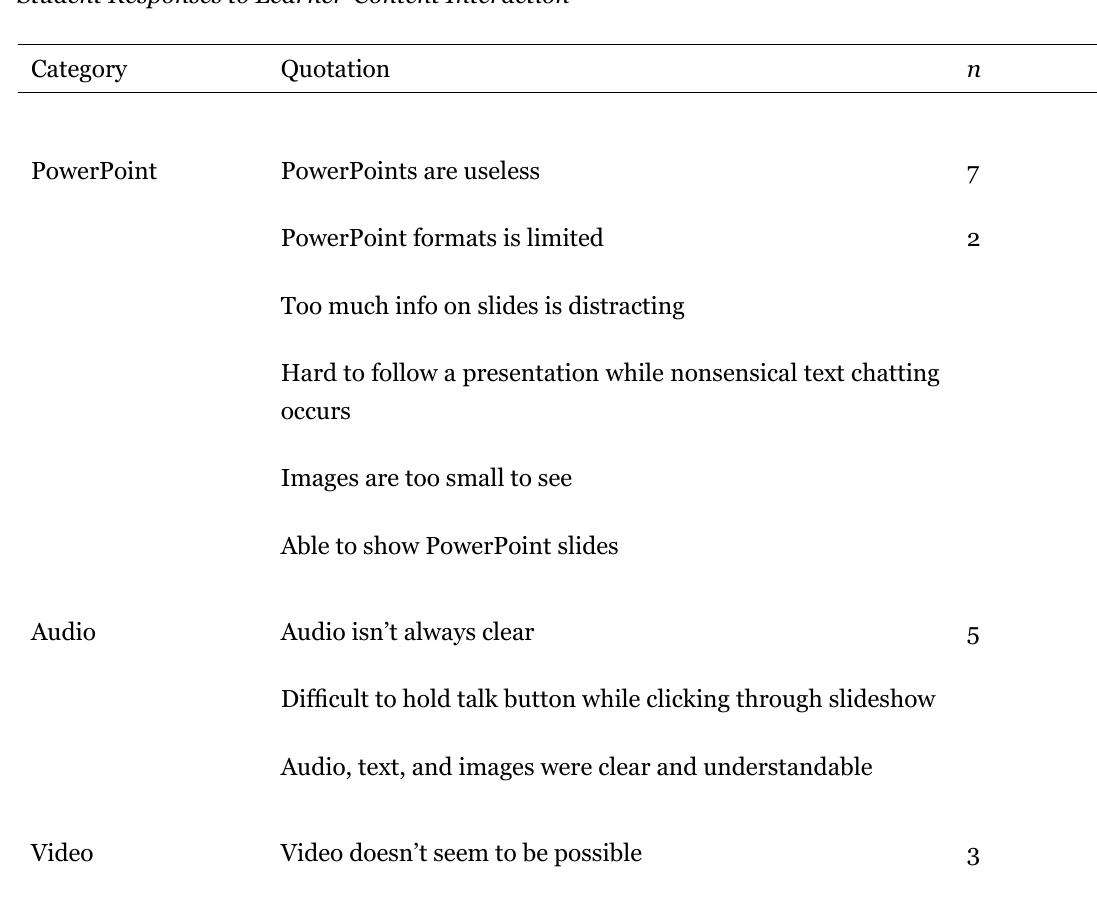
advantages, and disadvantages. Table 5 Student Responses to Learner-Content